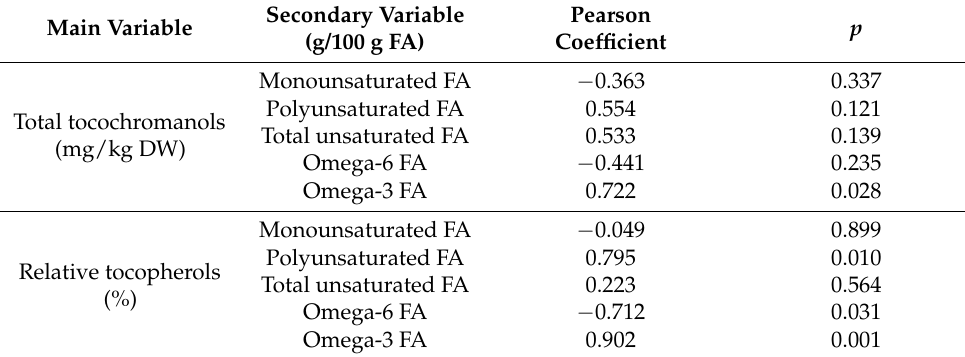
Table 4. Pearson correlation coefficient and associated probability ( p ) between vitamin E and fatty acid (FA) content in Chlorella sorokiniana , Nannochloropsis limnetica and Tetraselmis suecica